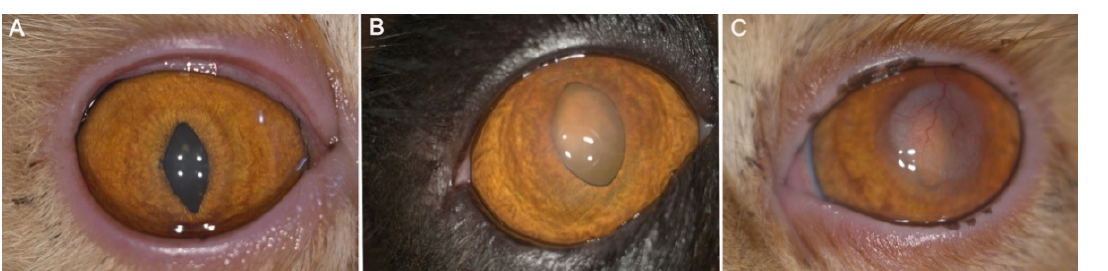
Figure 4. Grading of corneal healing after BioCorneaVet TM lamellar keratoplasty. ( A ) Grade 0, al- most invisibility of corneal scarring and vessels; ( B ) Grade 1, minimal corneal stroma opacity and vascularization; ( C ) Grade 2, mild to moderate corneal stroma opacity and vascularization; ( A – C ) Case number: 3, 2 and 8. Figure 3. Potential complications after acellular bioengineering cornea lamellar keratoplasty. ( A , B ) Protrusion of the graft (3–4 weeks post-op); ( C ) Obvious vascularization of the graft (2–3 weeks post-op); ( D ) Partial dehiscence of the graft (2 weeks post-op); ( A – D ) Case number: 6, 12, 53 and 29.